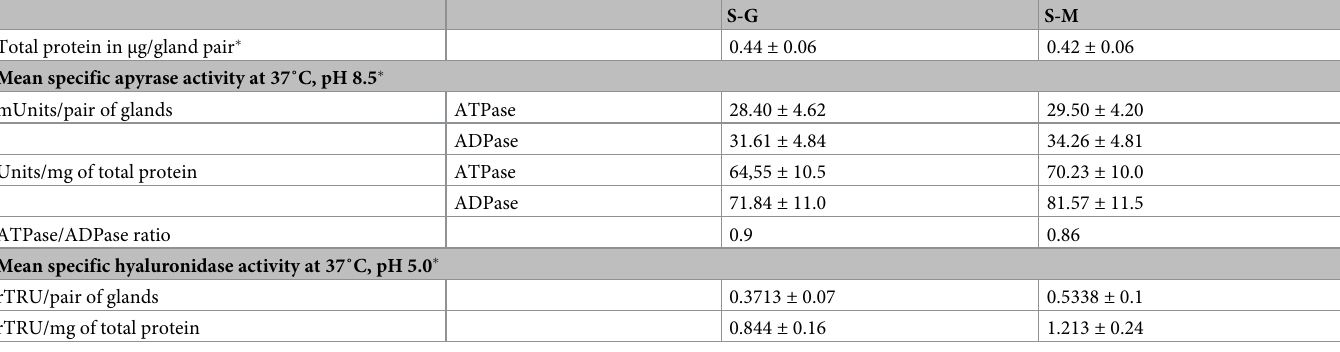
Table 3. Salivary apyrase and hyaluronidase in two S . schwetzi lineages maintained on different blood-meal sources, geckos (S-G) and mice (S-M).